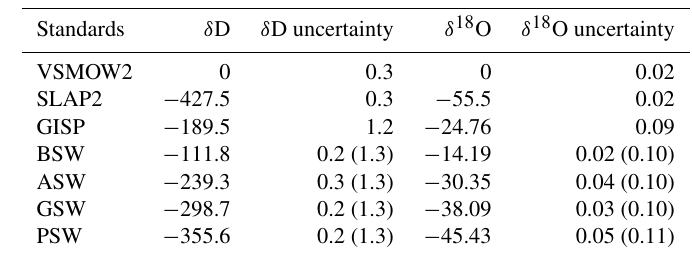
Table 2. Water isotope standards in units of per mil (‰). The laboratory standards (BSW, ASW, GSW, and PSW) were calibrated to primary standards (VSMOW2, SLAP2, and GISP) in March 2010. The primary standards are reported with errors given by the IAEA. The laboratory standards are reported with a precision value given by the average standard deviation (1 σ ) of multiple isotopic determinations across multiple analysis platforms (IRMS and CRDS). In parentheses, the combined uncertainty of the laboratory standard and each primary standard is given, added in quadrature.